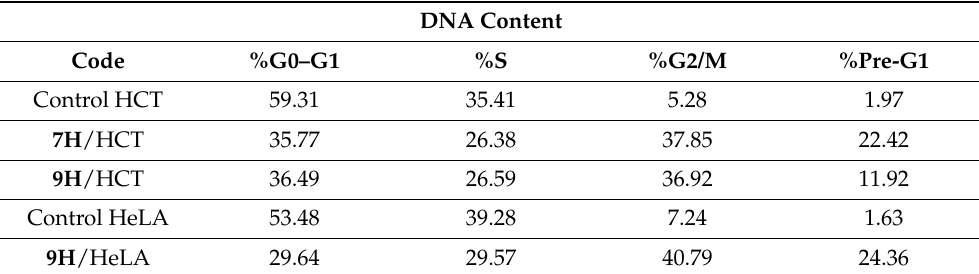
Table 9. Cell cycle analysis after incubation with 7H and 9H